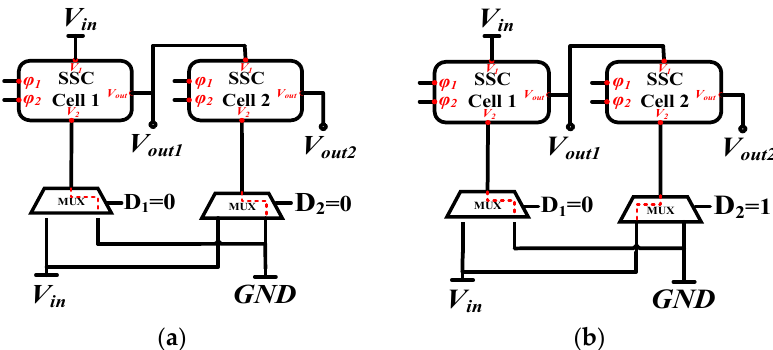
Table 1. Output capacitor size versus output voltage ripple for 4-bit SSC-DVS architecture.